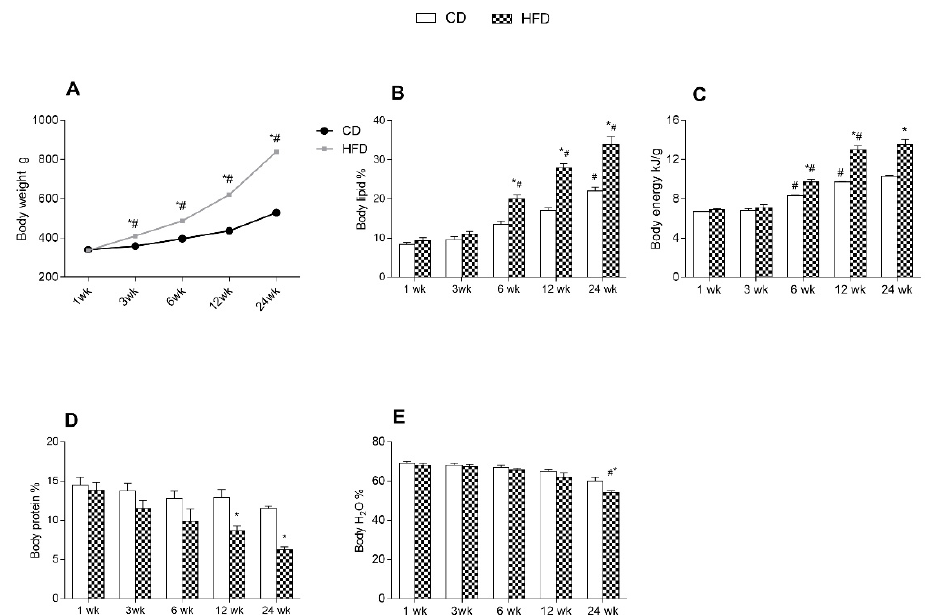
Figure 1. Effects of high-fat diet and aging on body weight and body composition. All the parameters were measured throughout the experimental period (1–24 weeks): ( A ) body weight; ( B ) body lipid; ( C ) body energy; ( D ) body protein and ( E ) body water are shown. Data are indicated as means ± SEM from n = 6 animals/group. # Significantly different compared to previous time point, p < 0.05; * significantly different compared to CD group, p < 0.05.